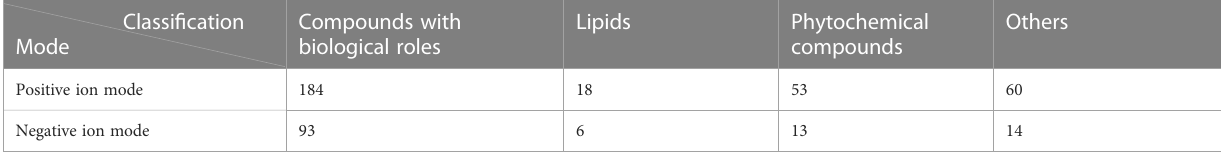
TABLE 2 Classi fi cation and number of metabolites detected in the positive and negative ion